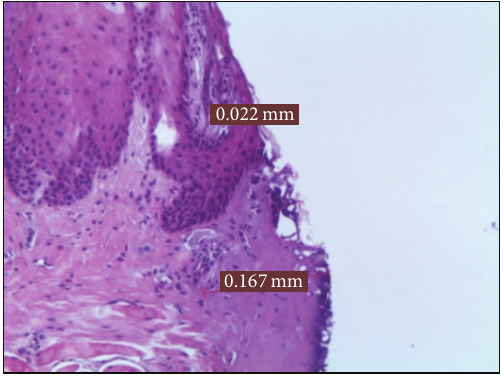
Figure 5: Histological specimen E 2 , using 3.5 watt in PW at 50 Hz, colour EE, magnification from original 40x.